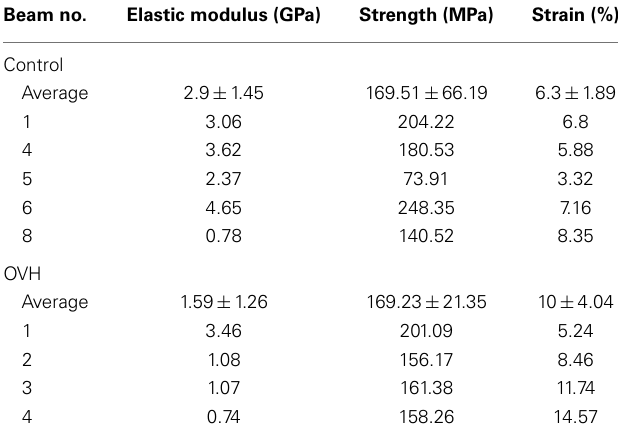
Table 2 | Elastic modulus, strength, and strain to failure values of both control and ovariectomized (OVH) rat femur bone micro-beams tested in compression